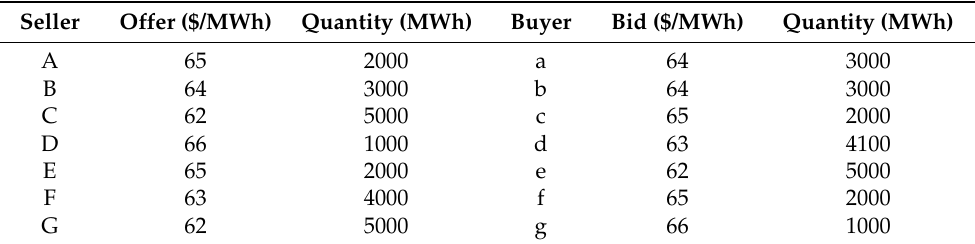
Table 2. Sellers/Buyers’ offer/bid amount and prices [27].